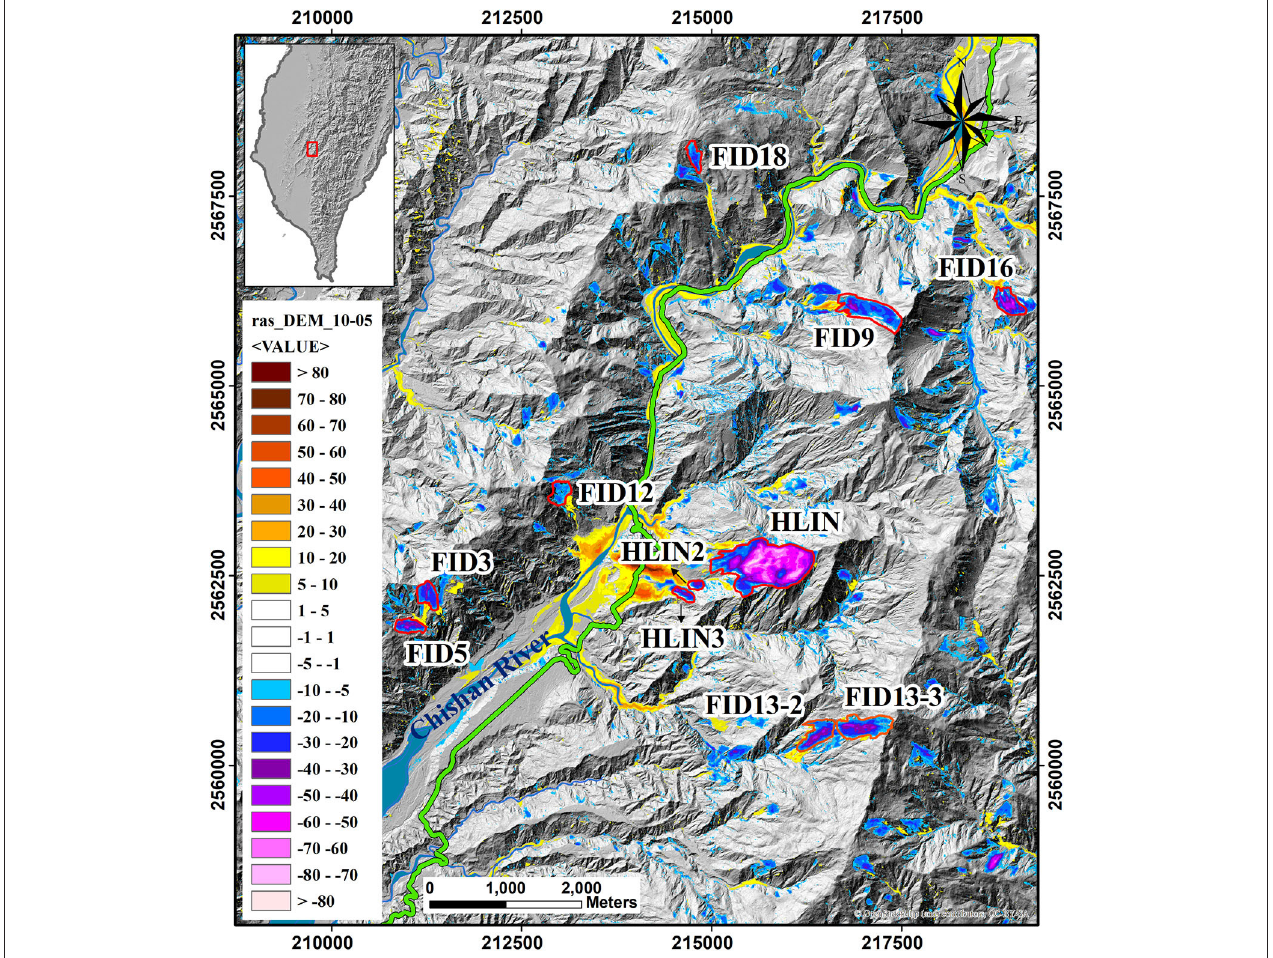
FIGURE 2 | Landslides in the Chishan River catchment, Jiaxian District, Kaohsiung City (Central Geological Survey, 2010). Negative values of the color legends indicate landslide scarp depths and the positive values indicate the deposit thickness in meters. The HLIN prefixes mark the Hsiaolin landslide and its associated landslides. The sites outlined in red solid lines are the deep-seated landslides investigated in the present study. The TWD97 coordinate system is